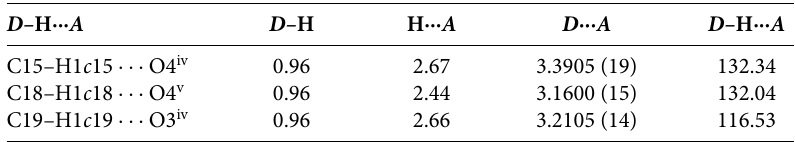
Table 3. Hydrogen-bond geometry (Å, º) for complex